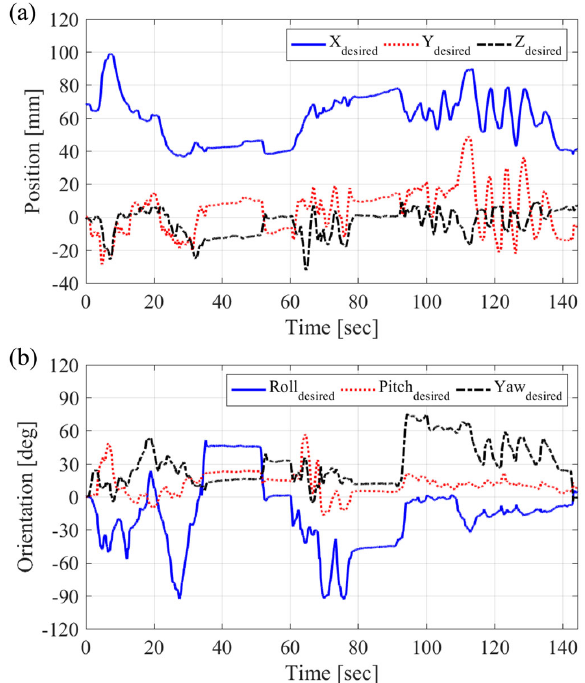
Figure 11. Desired position and orientation of end ‐ effector of robot arm, which is recorded by the haptic master device, as it simulates a suturing motion: ( a ) position; ( b ) orientation.